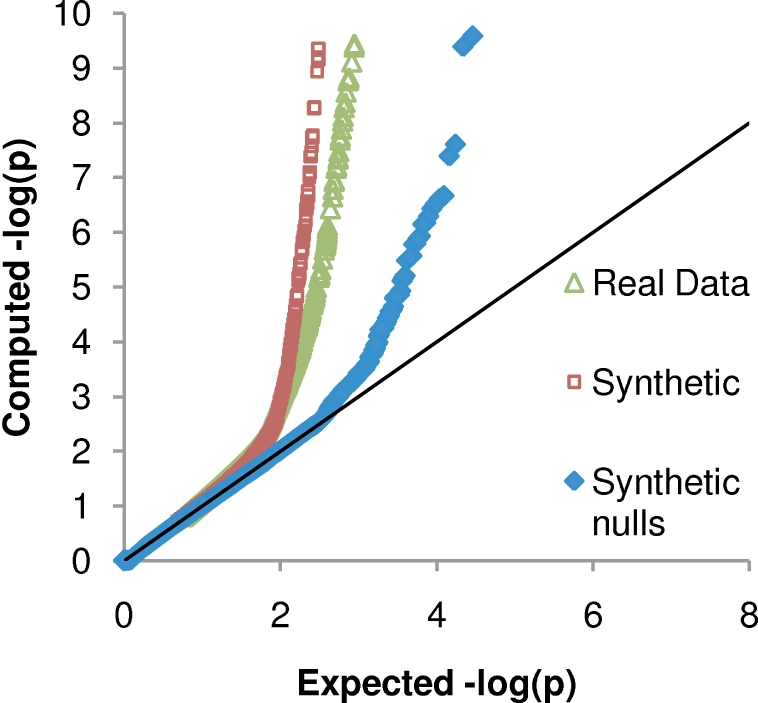
Quantile-Quantile (QQ) plot of p-values on the mixed clade cohort.Values correspond to −log10(p).